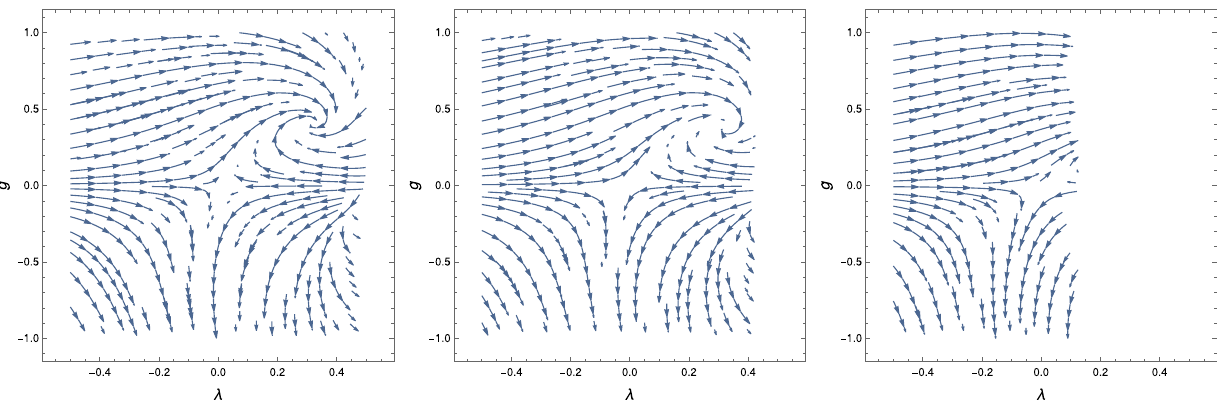
Fig. 4 Flow diagrams for the expansion made around C i R for m 2 is known as the inverse modified propagator [7]. In order to compare the right and left hand side of (2) using the heat of these expressions, so an expansion is made around C i R according to N ( A + C s R ) − 1 = N A − 1 + N A − 2 C s R